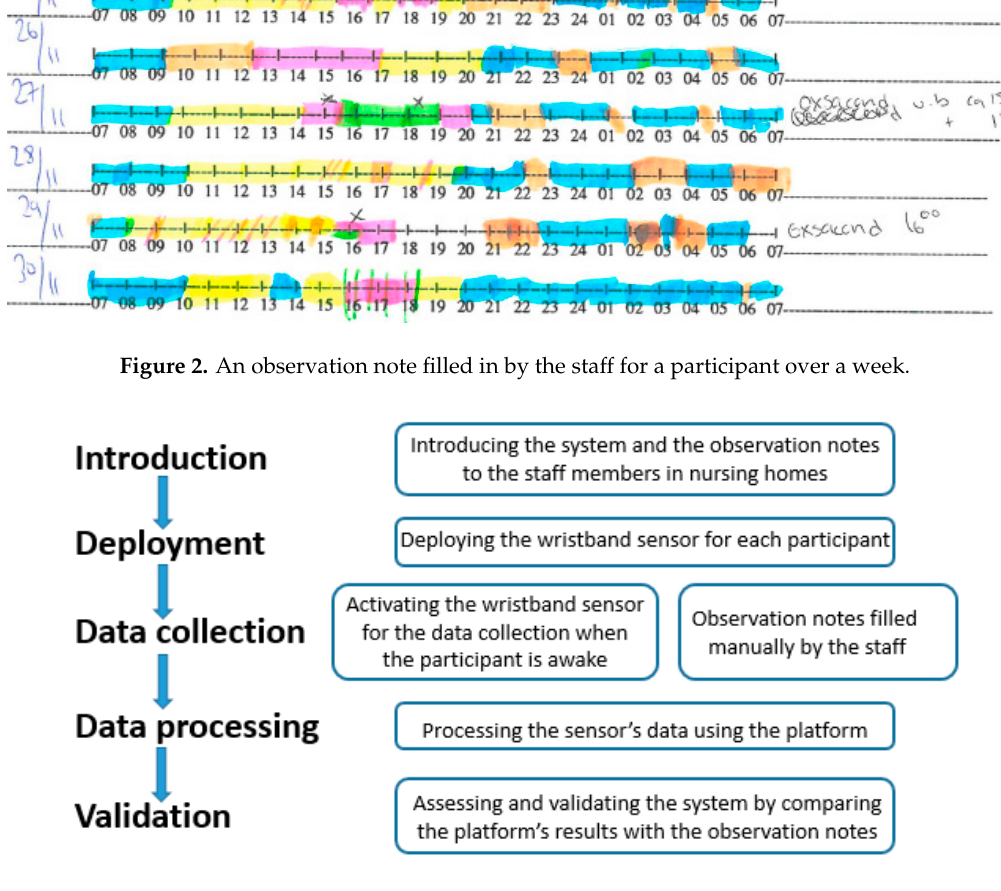
Figure 3. The overall design of the study.